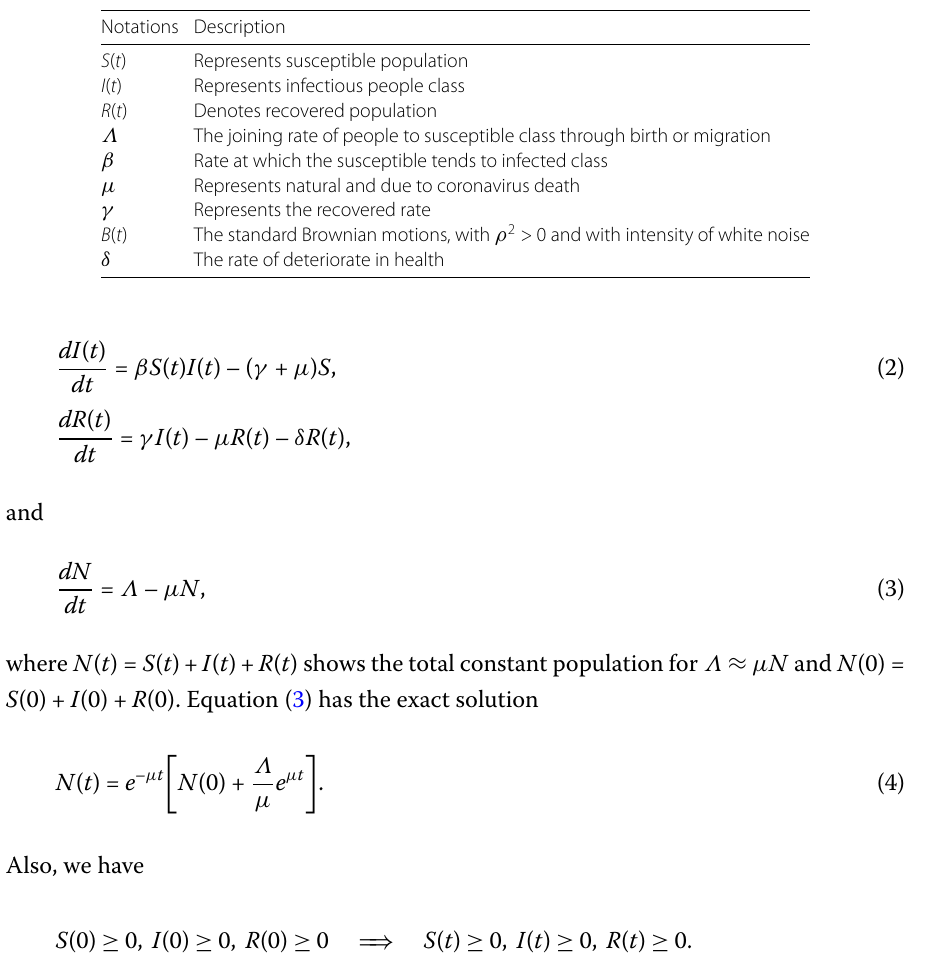
Table 1 Parameters and